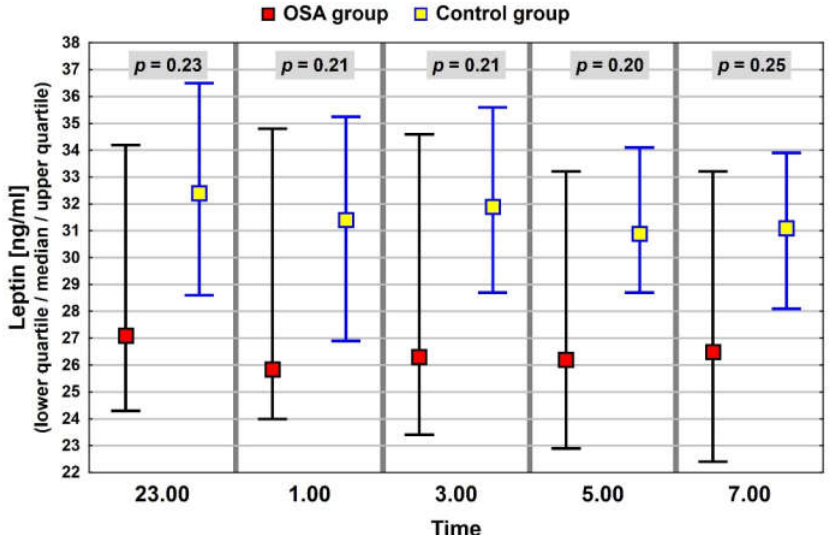
Figure 6. Night leptin values in groups of patients with and without OSA. The interquartile range (IQR) of neuropeptide concentrations is marked with black and blue lines.